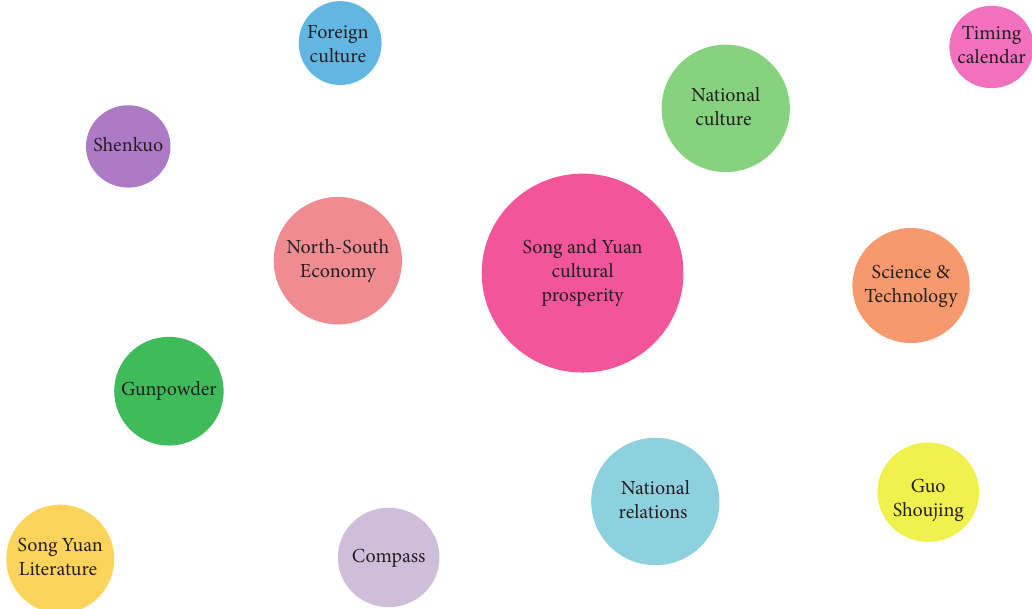
Figure 10: Visualization: knowledge point refinement